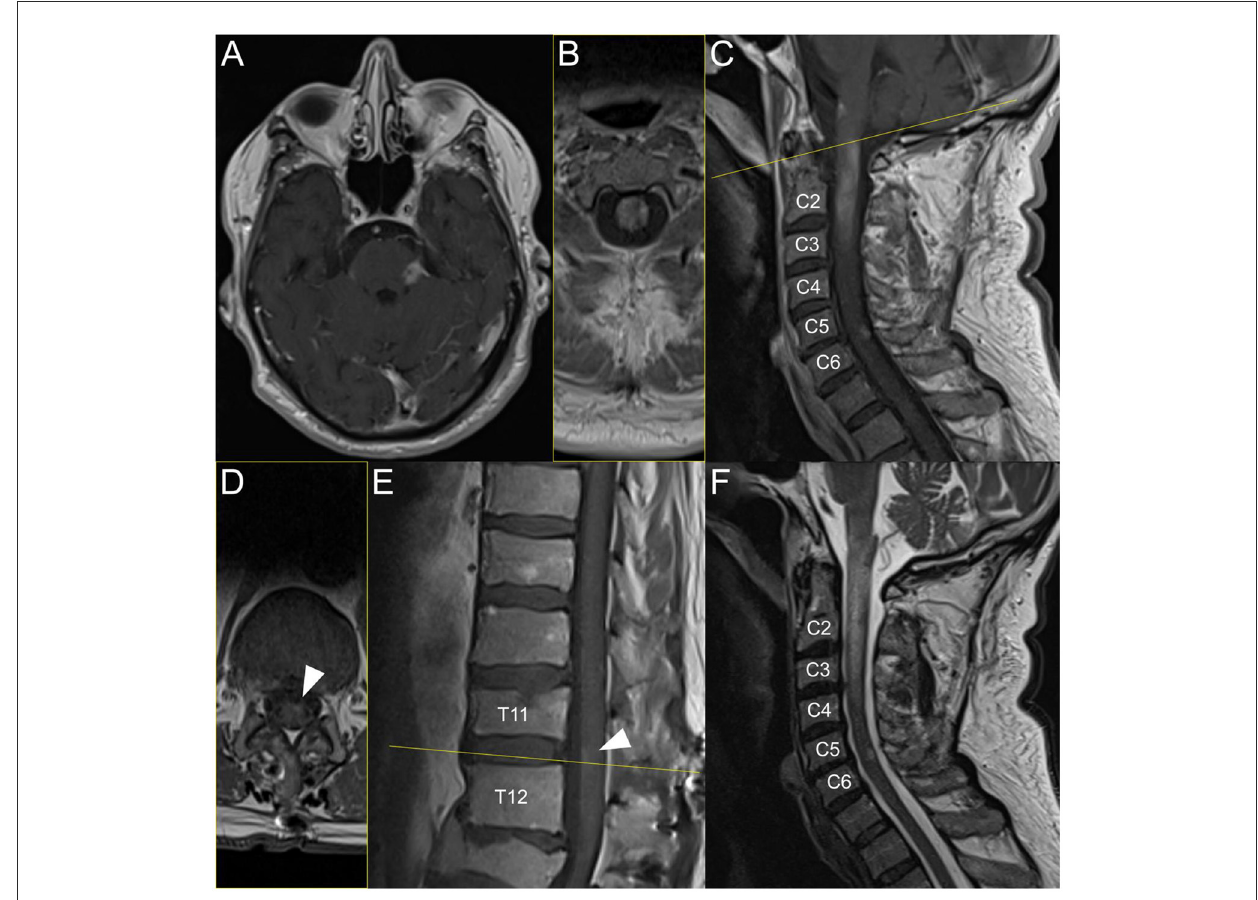
FIGURE1 Brain and spinal MRI during post-SARS-CoV-2 infection-induced ADEM. Acute inflammatory contrast-enhancing T1 MRI lesions on the left middle cerebellar peduncle (A) , longitudinal extensive transverse myelitis from the lower part of the medulla oblongata to C3 (C); [panel (B) shows axial plane, i.e., yellow line on panel (C)] with edema lesion on T2 (F) reaching C4, on level C5/C6 (C, F) , and on the ventral conus (E) ; [panel (D) shows axial plane, i.e., yellow line on panel (E) ].